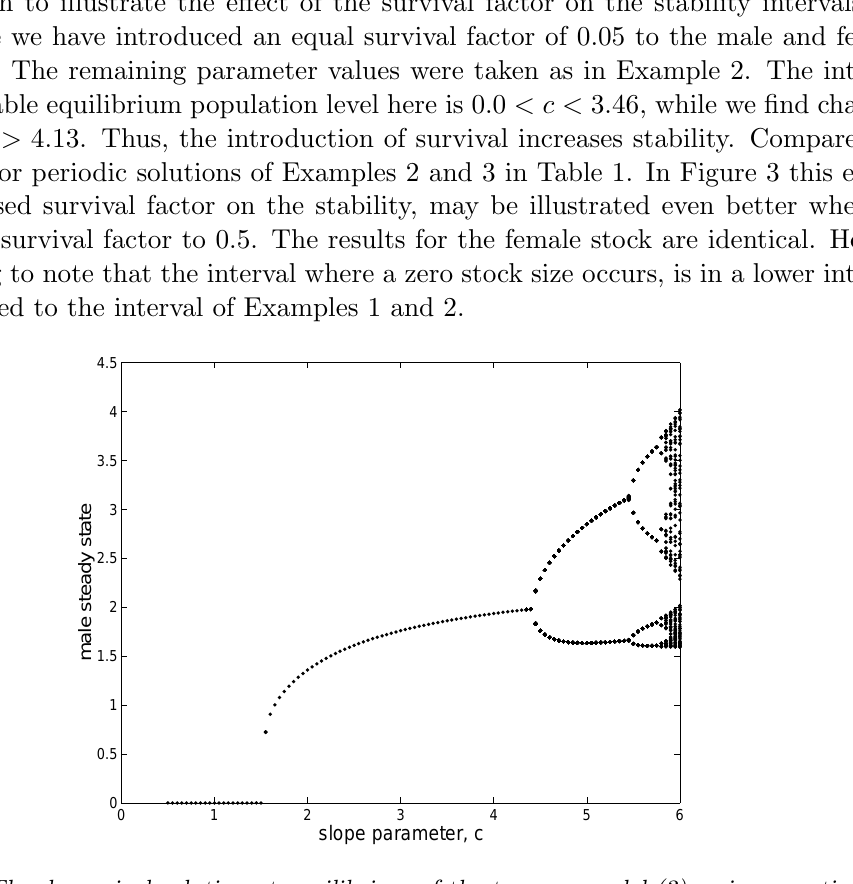
Figure 3: The dynamical solution at equilibrium of the two-sex model (3), using equations (5) and (6). Male stock against the parameter c , where θ = 0 . 5 , σ = 0 . 5 and the delay factors are u = v = 0 . 0